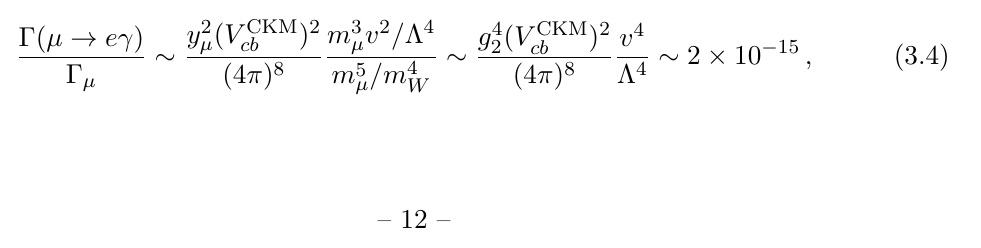
and for LFV processes in the NEW signal